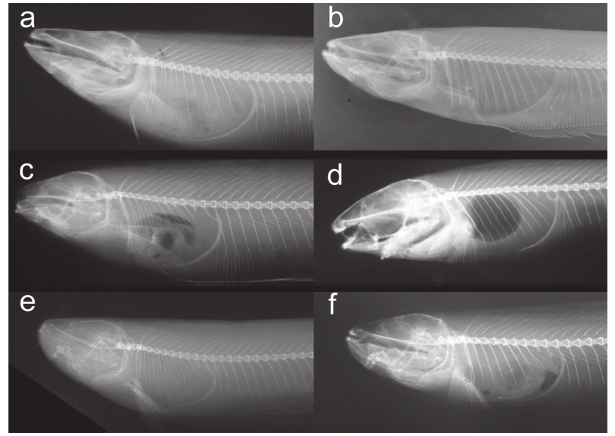
Fig. 6. Radiographs of six of the nine valid Sternarchella species . a. S. orthos (USNM 228871) . b. S. schotti (NMW 65335, holotype) . c. S. sima (AMNH 3864, holotype) . d. S. orinoco (USNM 228727). e. S. calhamazon (INPA 37898, holotype) . f. S. patriciae (MUSM 45239, holotype). Clade A ( S. sima clade): Comprised of Sternarchella species with a ventral mouth ( S. sima and S. orinoco ), and characterized by six synapomorphies. Pectoral fin large, 80% HL or greater. Oral aperture sub-terminal, upper jaw extends anteriorly to lower jaw. Four rows of teeth present on premaxilla. Three to four rows of teeth present on dentary. Endopterygoid large, contacting